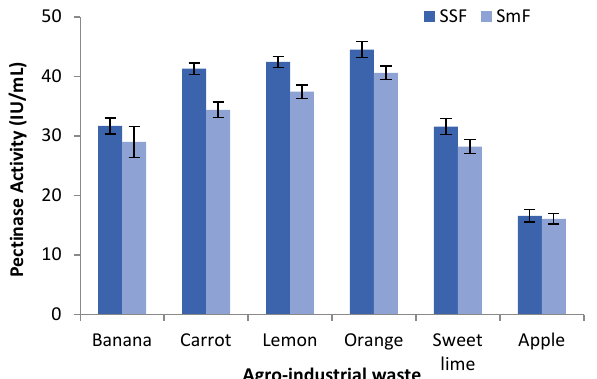
Figure 1. Comparison studies of pectinase activity for different agro-industrial waste using SmF and SSF .